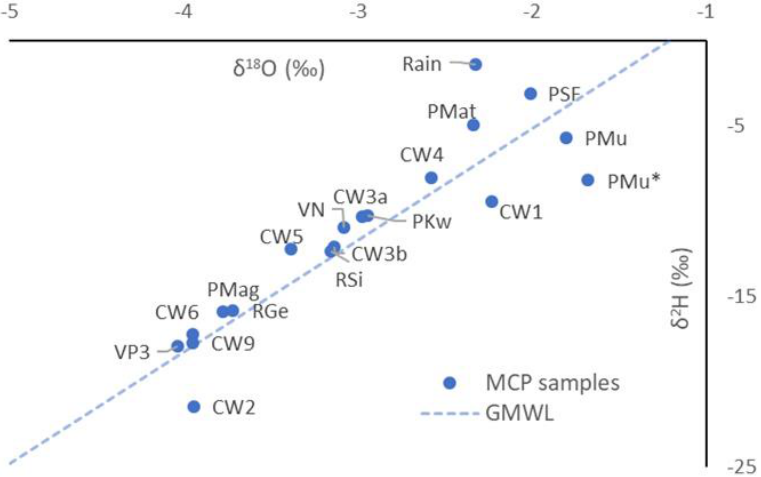
Figure 9. Stable isotopes content in water samples from the second campaign covering the northern part of the Maputaland Coastal